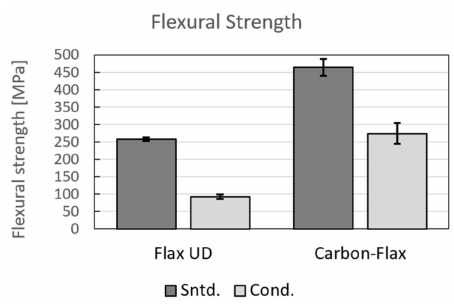
Figure 10. Flexural strengths of conditioned